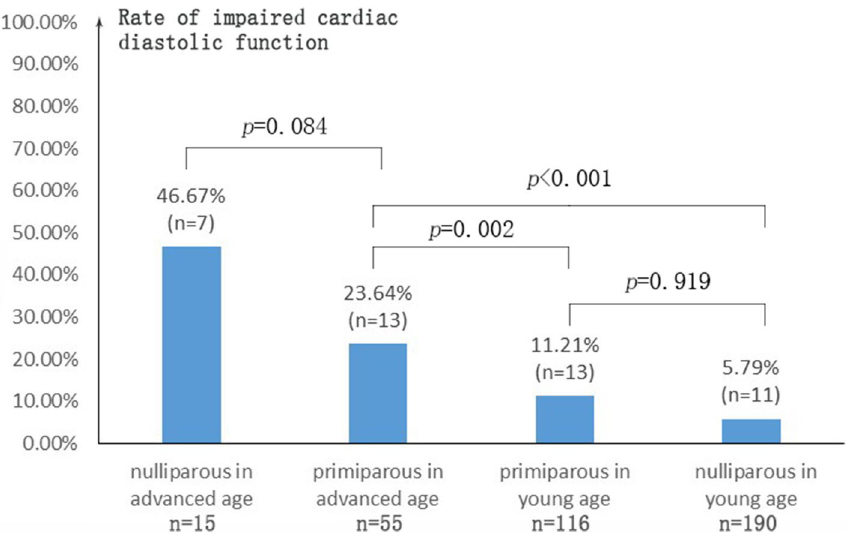
Figure 2. Rate of impaired cardiac diastolic function in different group divided by age and parity. Advanced age was defined as maternal age ≥ 35 years and young age was defined as maternal age < 35 years. Rate of impaired cardiac diastolic function was defined as number of impaired cardiac diastolic function in each group divided by total number of the corresponding group. Kruskal–Wallis test was used to analysis the statistical difference.